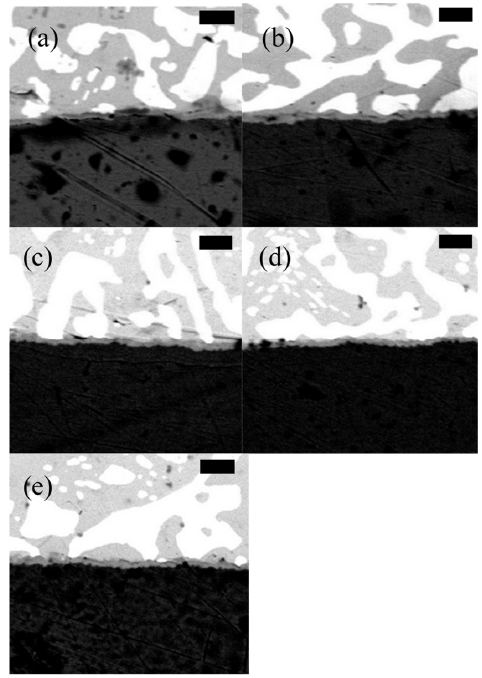
Figure 10. SEM images of 42Sn57Bi1Ag reflowed with ( a ) a peak temperature of 165 °C and 45 s TAL, ( b ) peak temperature of 165 °C and 90 s TAL, ( c ) peak temperature of 177 °C and 45 s TAL, ( d ) peak temperature of 177 °C and 90 s TAL and ( e ) peak temperature of 190 °C and 90 s TAL. The scale bar is 4 µm in all images.